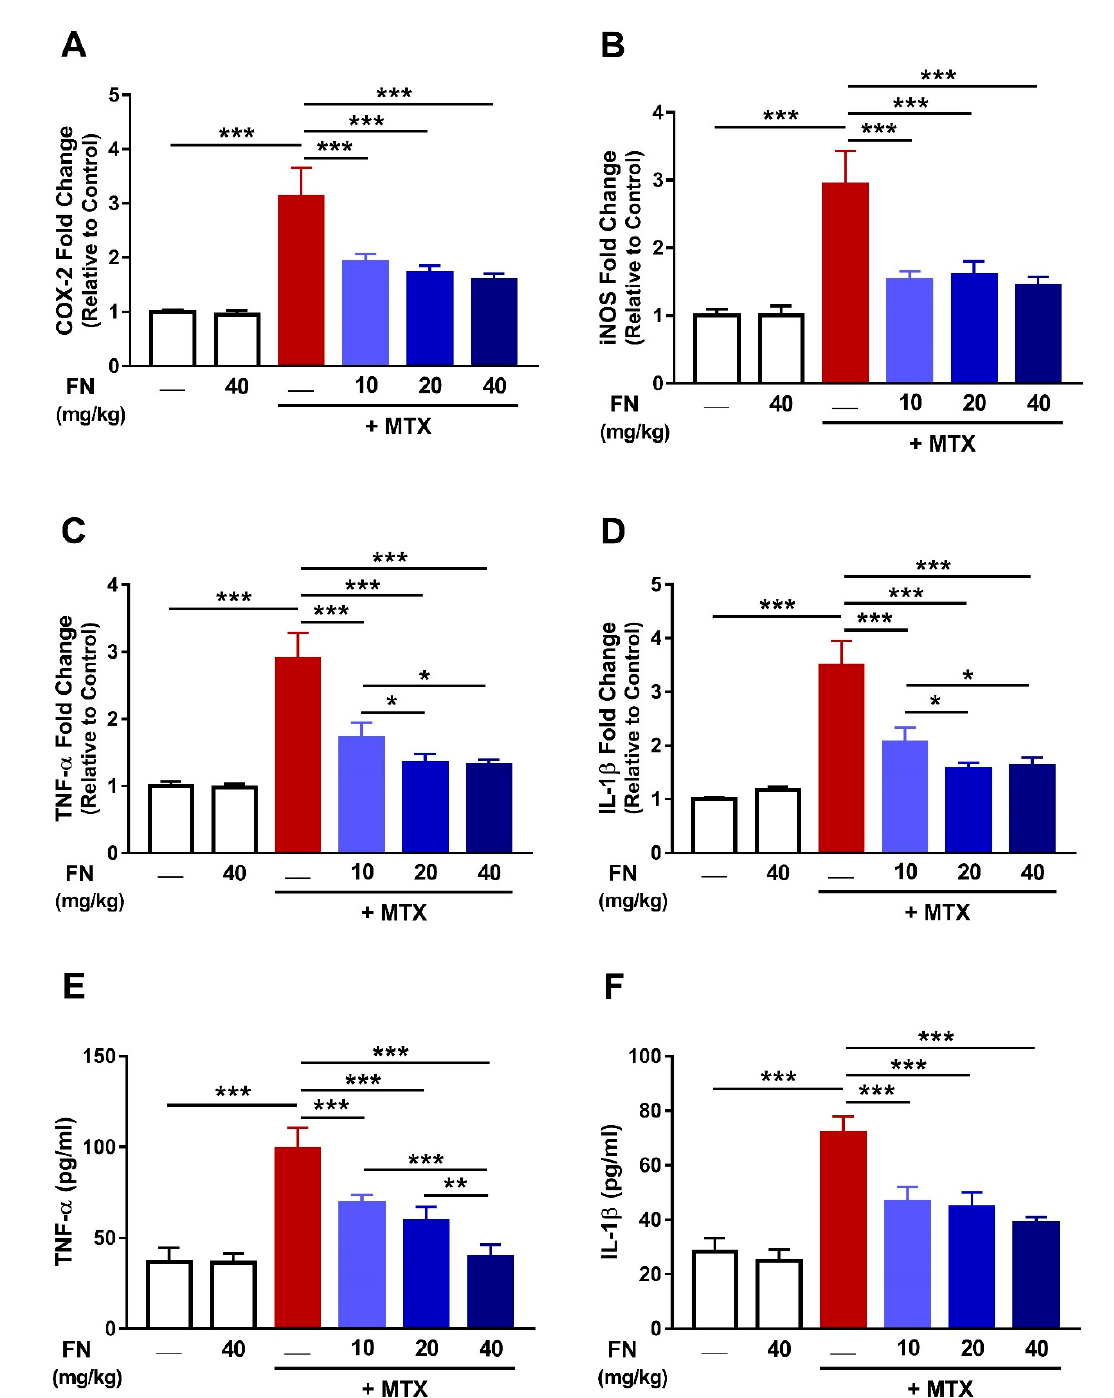
Figure 6. FN suppresses renal inflammation in MTX-induced rats. FN reduced mRNA abundance of renal COX-2 ( A ), iNOS ( B ), TNF α ( C ), and IL-1 β ( D ), and serum TNF α ( E ) and IL-1 β ( F ) in rats which received MTX. Data are mean ± SEM, ( n = 6). * p < 0.05, ** p < 0.01 and *** p < 0.001.